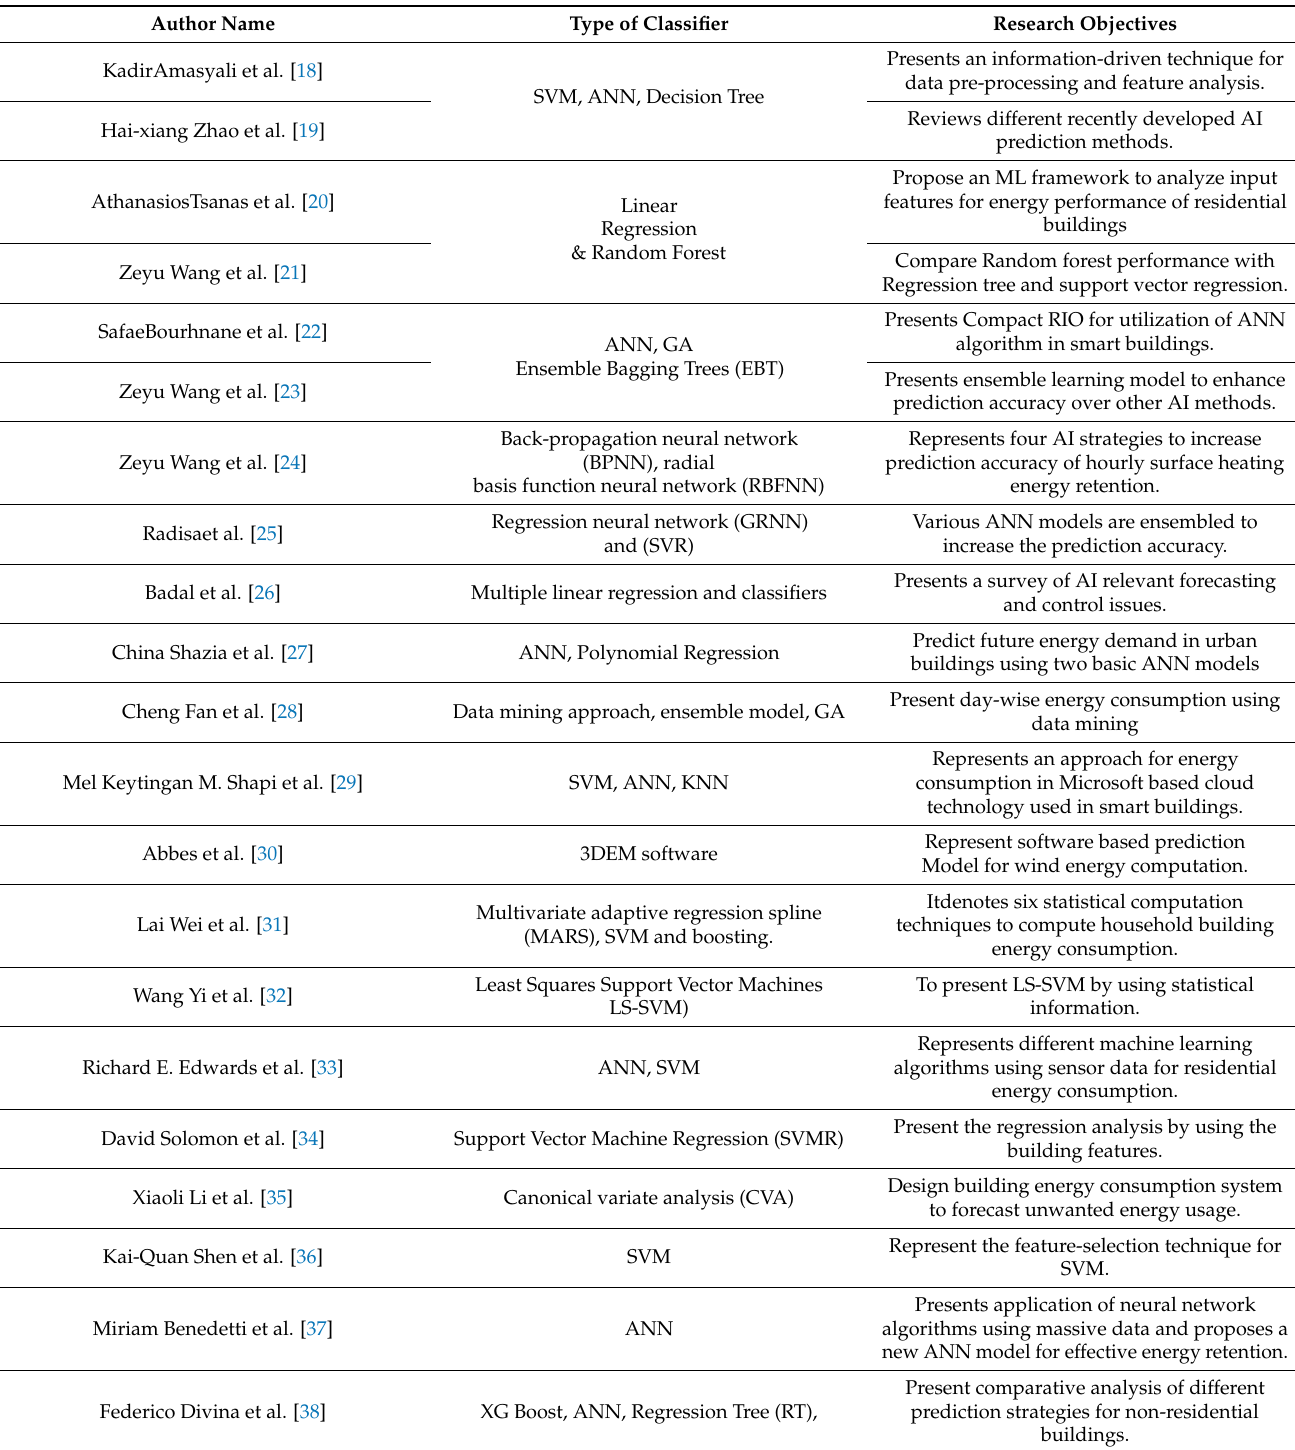
Table 2. Distribution of the algorithms based on the machine learning